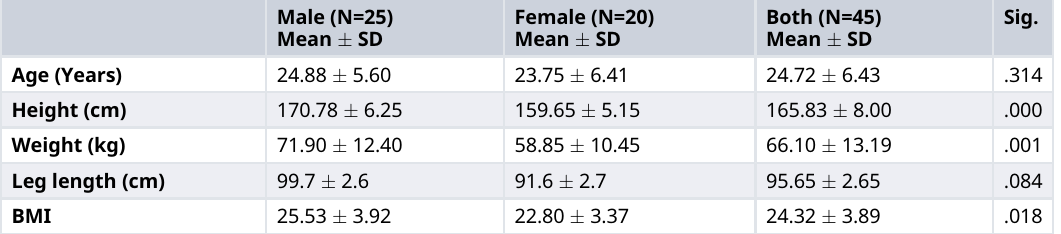
Table 1. Anthropometric measurement of